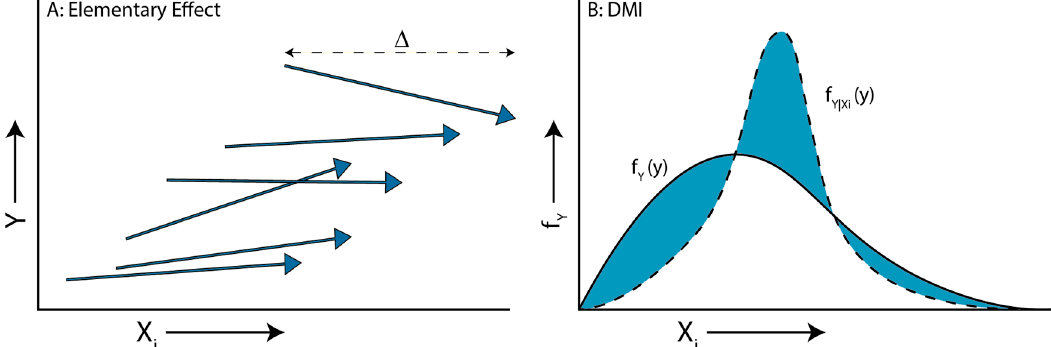
Figure 4. Visual explanation of both SA methods used. The elementary effect EE ( A ) uses a fixed step ( δ i , equation 3) of input factor X i from a random starting points and measures the change in result Y. Note that all arrows are of the same size in the X direction, representing the fixed step size. The DMI method ( B ) is based on the area difference (highlighted in red) between the continuous unconditional probability density function f Y ( y ) and a conditional unconditional probability density function f (cid:2909)|(cid:2908) ( y ) , which is based on a sample of the unconditional input